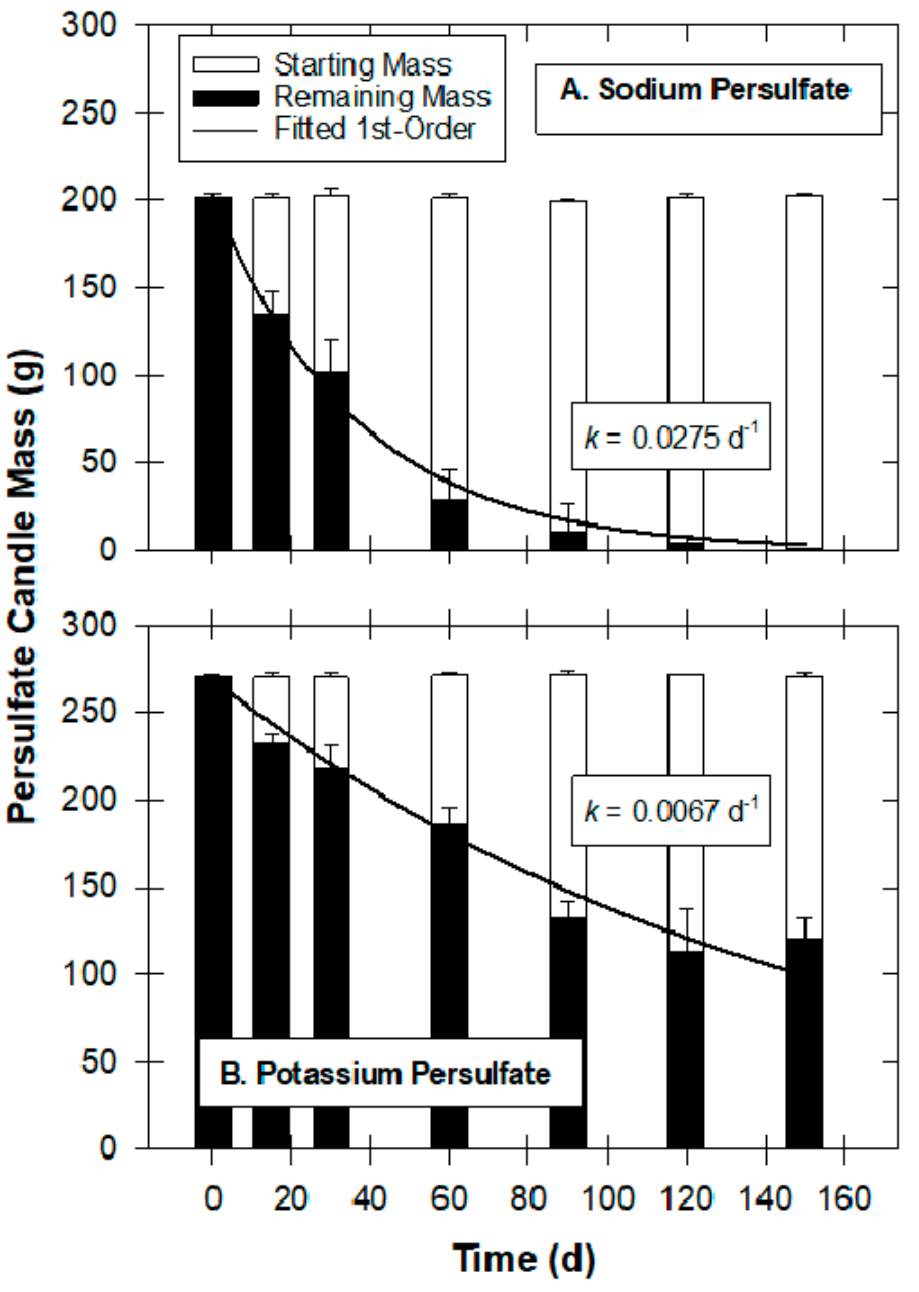
Figure 8. Temporal changes in persulfate mass in field-deployed oxidant candles at the Textron site; ( A ) sodium persulfate candles and ( B ) potassium persulfate candles. Open bars show candle weights at T = 0 d; solid bars show candle weights once removed from the aquifer and dried.